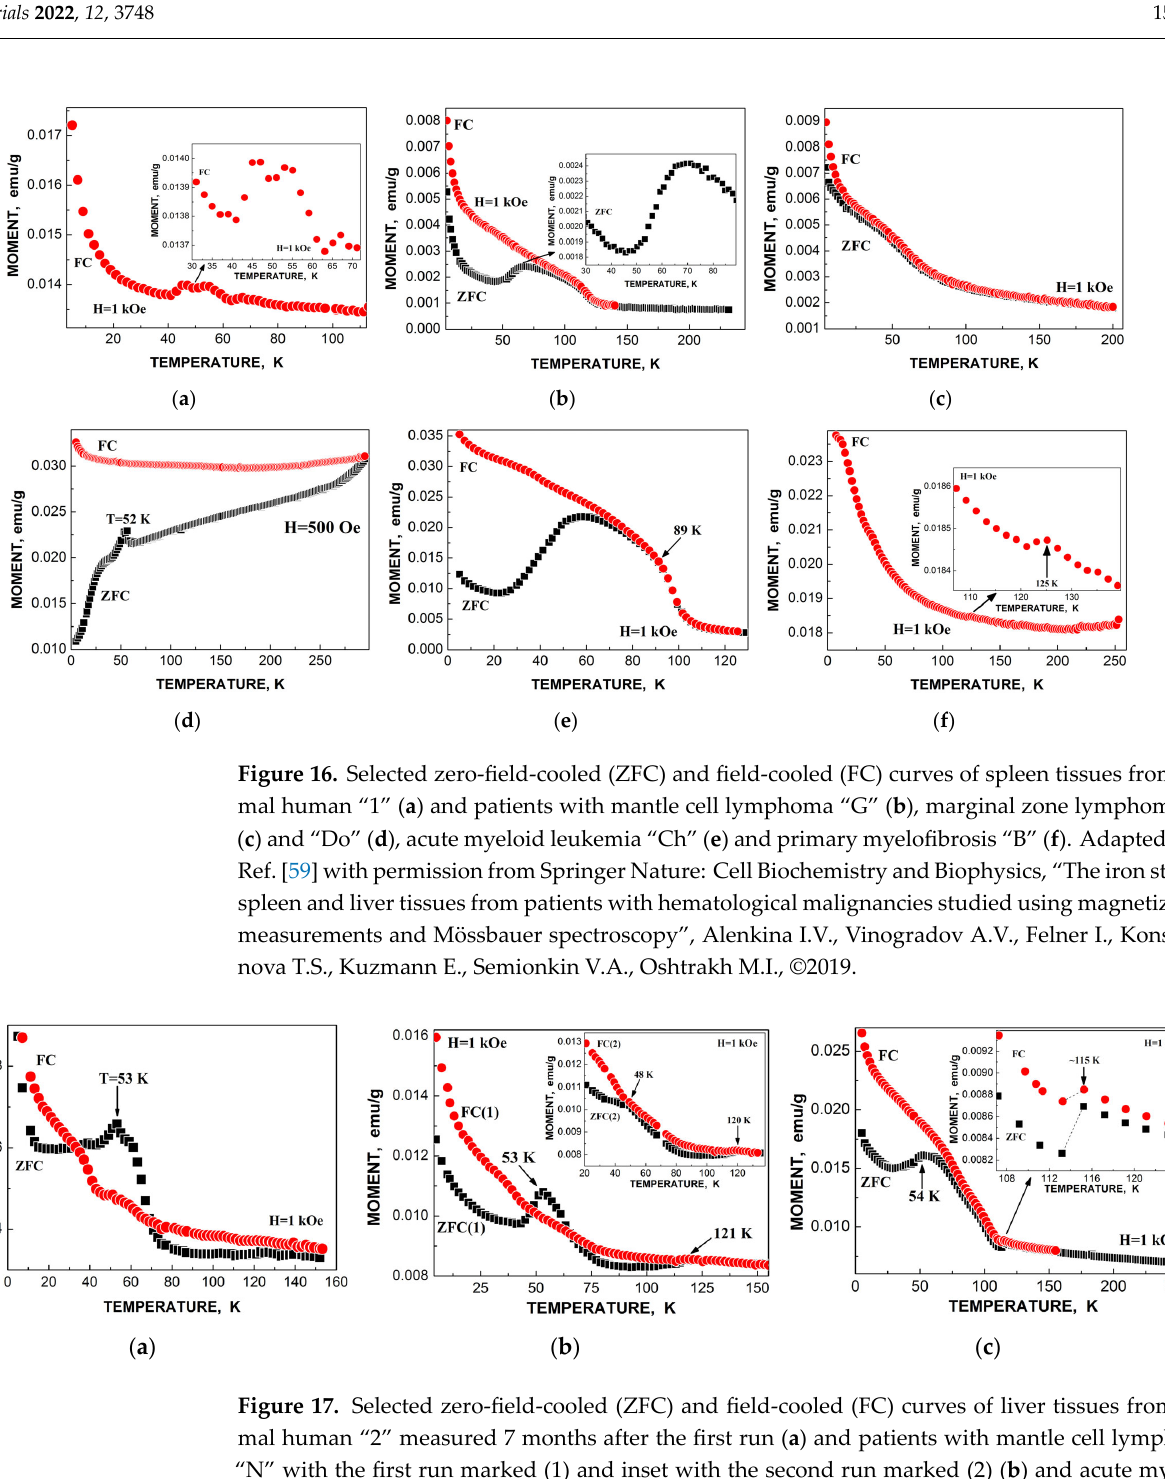
Figure 15. Plots of the 57 Fe hyperfine parameters for ferritin ‐ like components 1 ( a , c ) and 2 ( b , d ) in the Mössbauer spectra of spleen ( a , b ) and liver ( c , d ) tissues from healthy human and patients with hematological malignancies. Adapted from Ref. [59] with permission from Springer Nature: Cell Biochemistry and Biophysics, “The iron state in spleen and liver tissues from patients with hema ‐ tological malignancies studied using magnetization measurements and Mössbauer spectroscopy”, Alenkina I.V., Vinogradov A.V., Felner I., Konstantinova T.S., Kuzmann E., Semionkin V.A., Osh ‐ trakh M.I., ©2019.